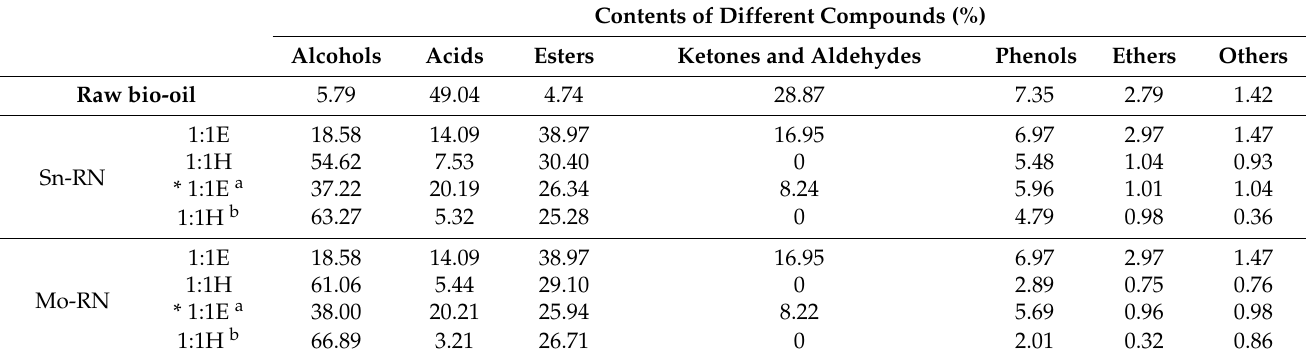
Table 4. The product distribution after two steps of upgrading over modified Raney Ni